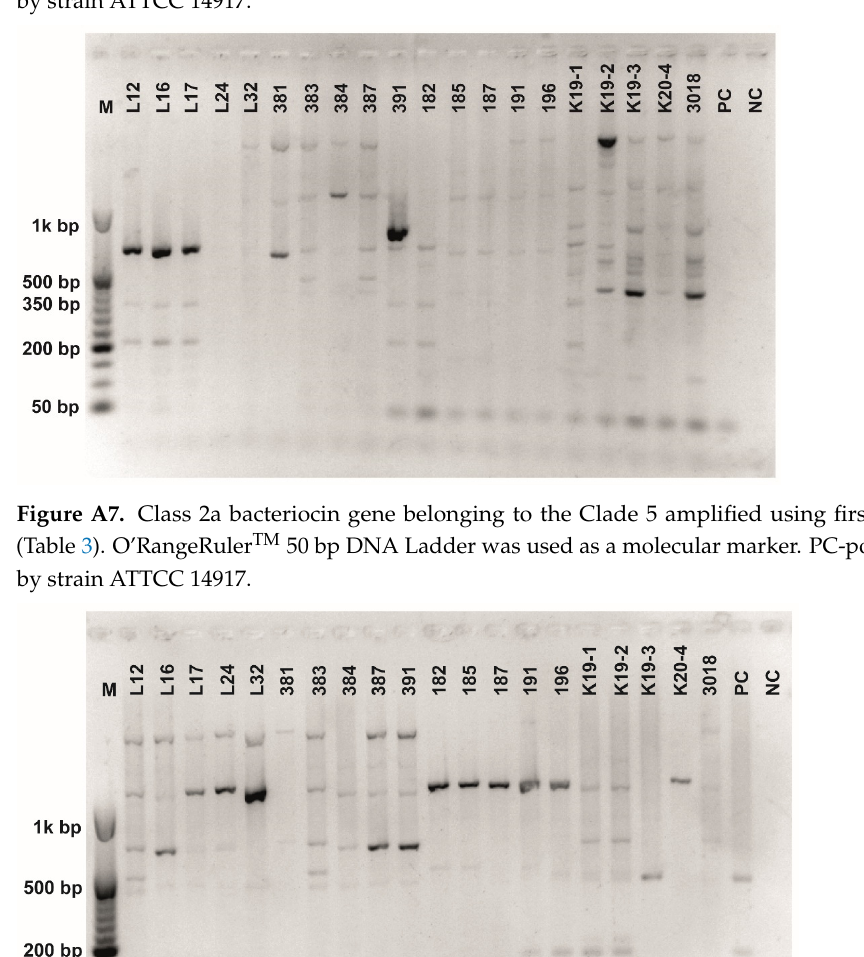
Figure A6. Class 2a bacteriocin gene belonging to the Clade 4 amplified using second primer pair (Table 3). O’RangeRuler TM 50 bp DNA Ladder was used as a molecular marker. PC-positive control by strain ATTCC 14917.